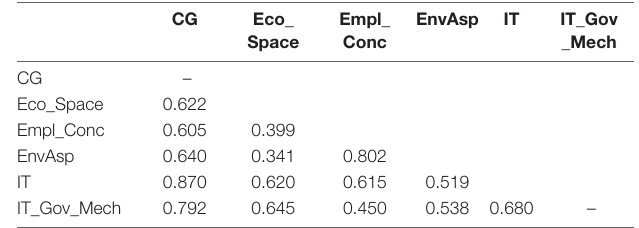
TABLE 4 | HTMT ratio.